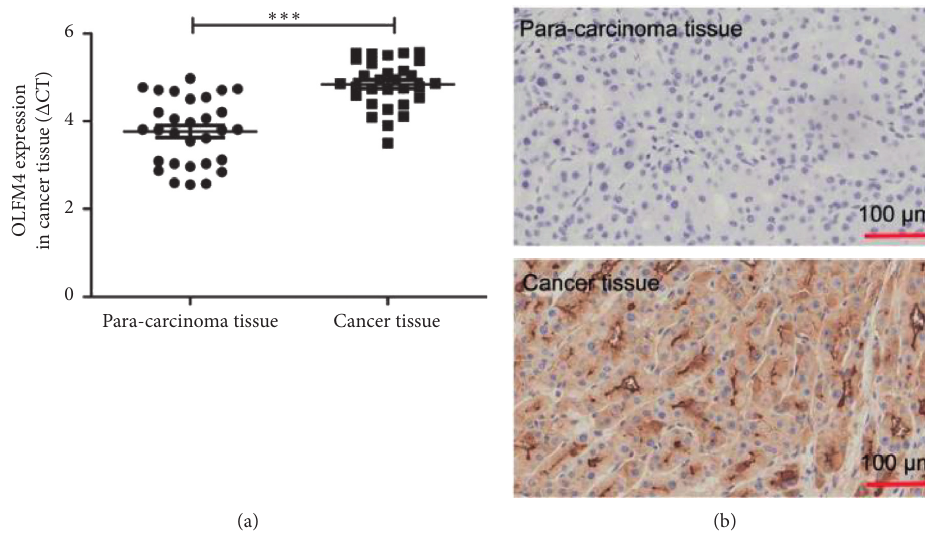
Figure 2: mRNA and protein levels of OLFM4 in paracarcinoma tissue and cancer tissue in HCC patients. (a) mRNA expression of OLFM4 in paracarcinoma tissue and cancer tissue in HCC patients measured by qRT-PCR assay, ∗∗∗ P < 0 . 001; (b) protein levels of OLFM4 in paracarcinoma tissue and cancer tissue in HCC patients measured by IHC assay.